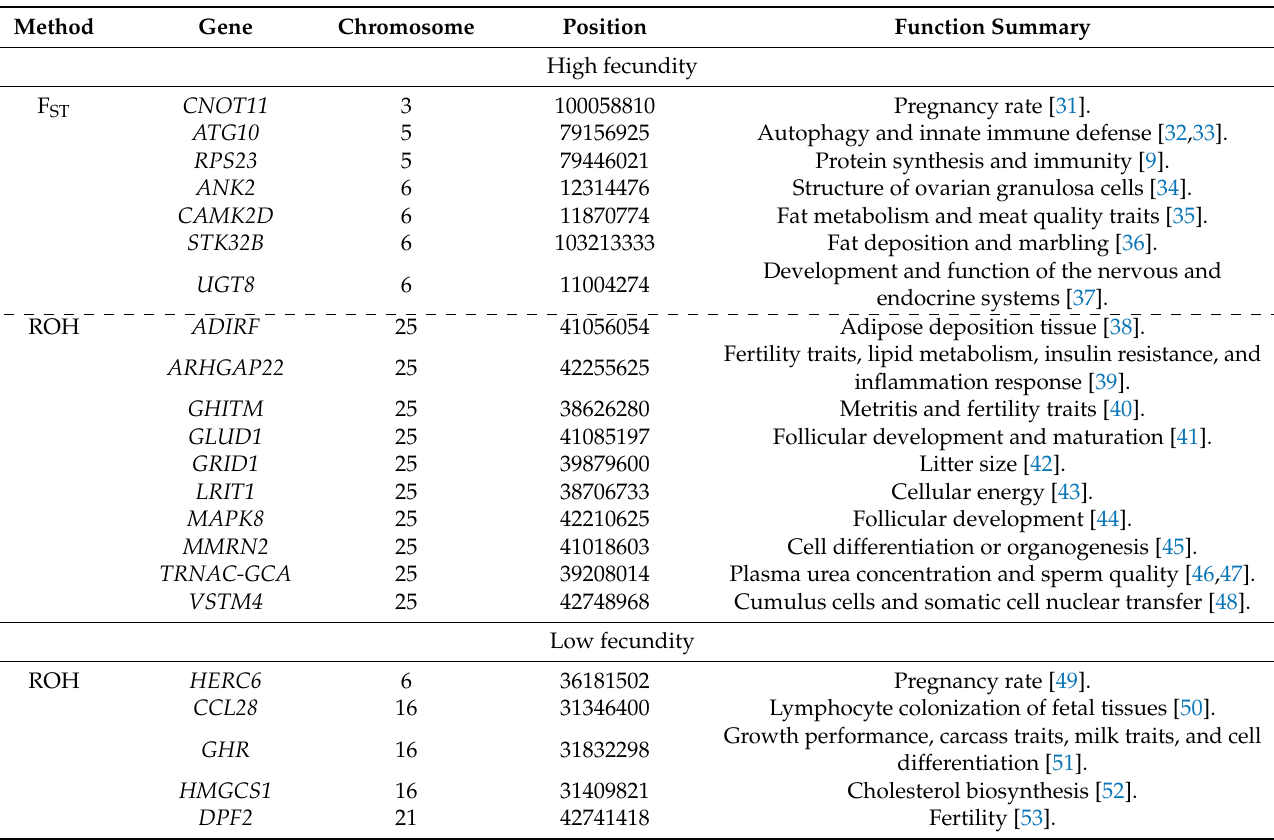
Table 2. Candidate genes putatively selected by two statistical methods of selection signature detection affecting fecundity in Katahdin ewes and reproduction traits reported in other